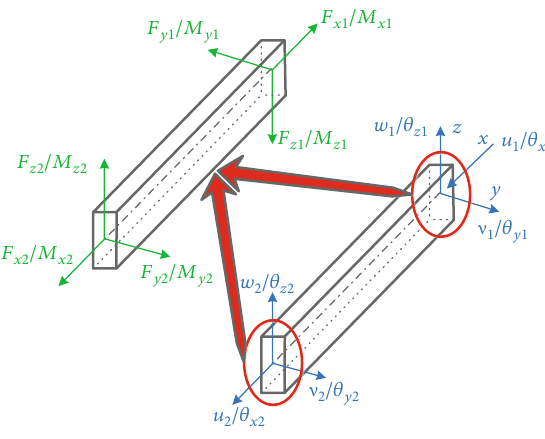
Figure 3: The local coordinate system of pileSEL and the positive direction of the force and bending moment of the structural elements [30].